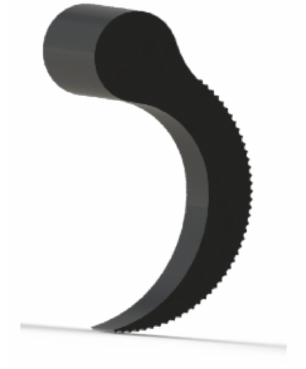
Figure 13. Leg CAD render.